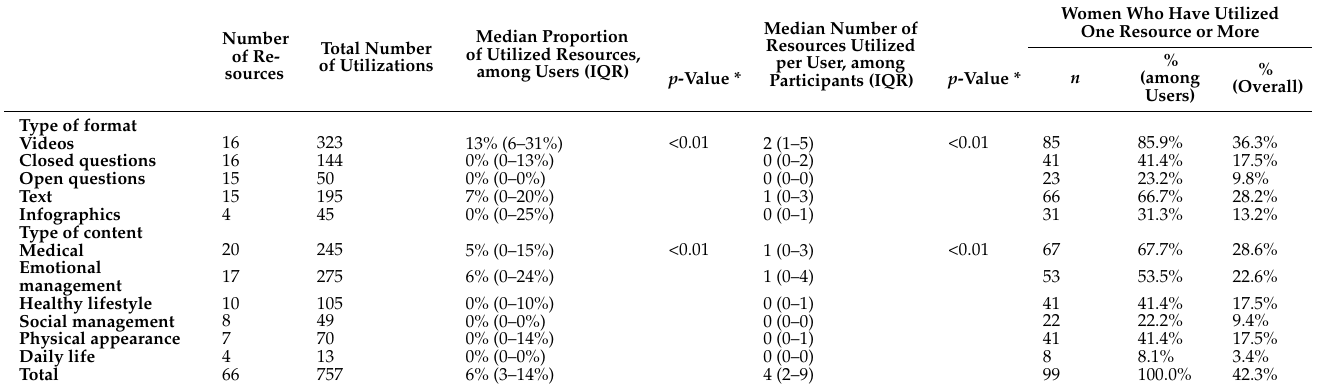
Table 2. Utilization of resources by